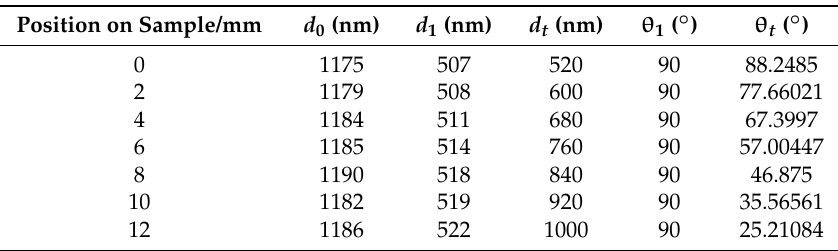
Table 1. Revised data of LVF with the